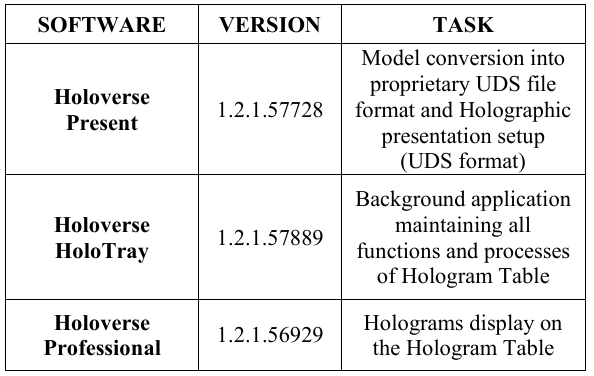
Table 1 . Euclideon Holographic software, versions, and tasks.